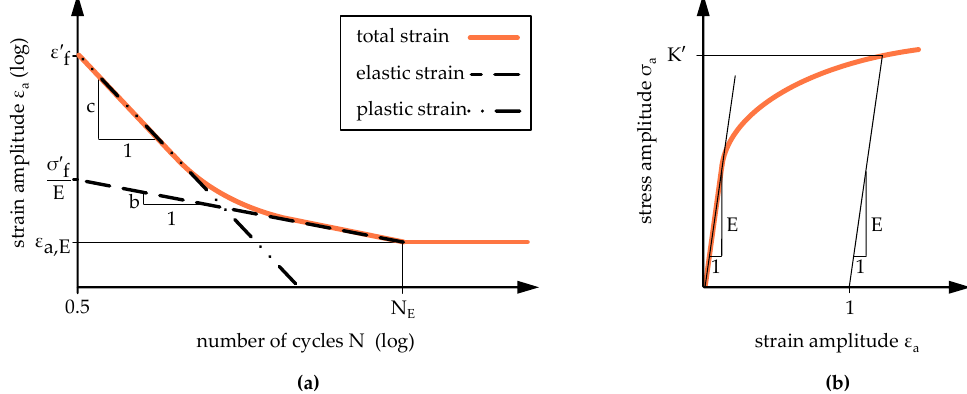
Figure 3. ( a ) Strain–life curve according to Co ffi n and Manson amended by fatigue strength ε a,E and ( b ) cyclic stress–strain curve according to Ramberg and ( b ) cyclic stress–strain curve according to Ramberg and Osgood.